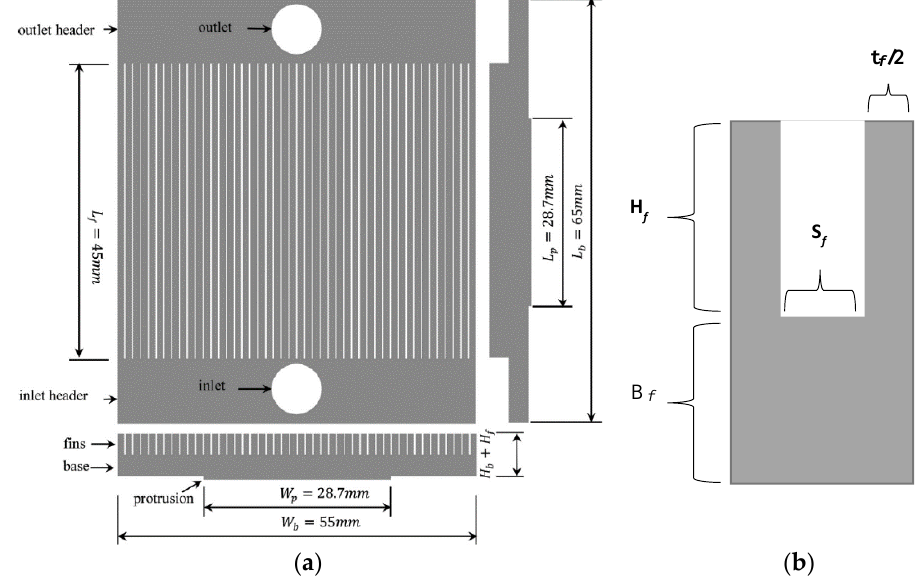
Figure 1. ( a ) Schematic of the entire heatsink [11]; ( b ) a single mini-channel. Table 1. Specifications of the case study .